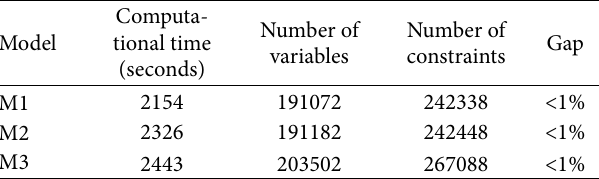
Table 2: The computational performances of the three